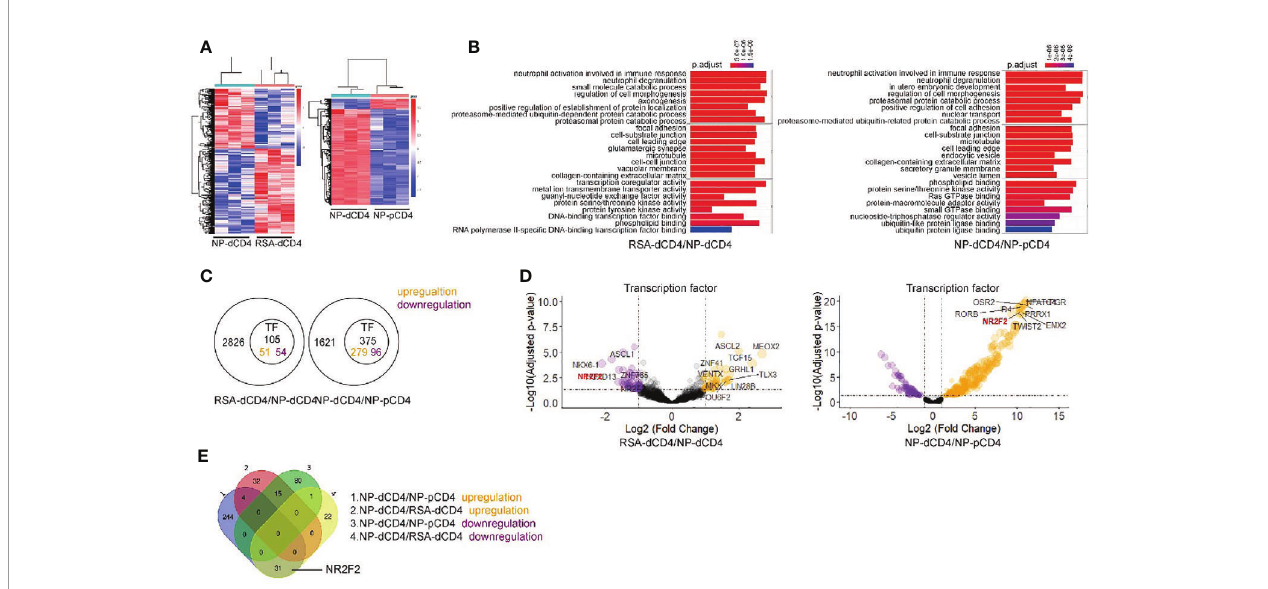
FIGURE 1 | Transcriptional analysis of CD4 + T cells from peripheral blood and decidua. (A) Heatmap result of an unsupervised hierarchical clustering of genes that is signi fi cantly different ( p <0.01) in dCD4 + T cell samples from RSA compared with dCD4 + T cells from NP (left). Heatmap result of differential gene in samples of dCD4 + T cells compared with samples of pCD4 + T cells from NP (right). Each column represents a patient (blue: NP-dCD4 + T cells, red: RSA- dCD4 + T or NP- pCD4 + T cells), and each row represents a gene. The heatmap indicates the level of row normalized gene expression. Red=high expression; Blue=low expression. (B) GO analysis of differentially expressed genes. (C) 51 upregulated and 54 downregulated transcriptional factor genes in 2826 differentially expressed genes of early RSA dCD4 + T cells. And 279 upregulated and 96 downregulated transcriptional factor genes in 1621 differentially expressed genes of NP dCD4 + T cells. (D) Volcano plot and (E) Venn diagram of differentially expressed transcriptional factor genes; orange and purple points mark the genes with signi fi cantly increased or decreased expression, respectively, in samples of dCD4 + T cells from RSA compared with dCD4 + T cells from NP (FDR<0.01, left). Volcano plot in samples of dCD4 + T cells compared with samples of pCD4 + T cells from NP (FDR<0.01, right). The x-axis shows Log 2 (Fold Change) in expression, and the y-axis shows the